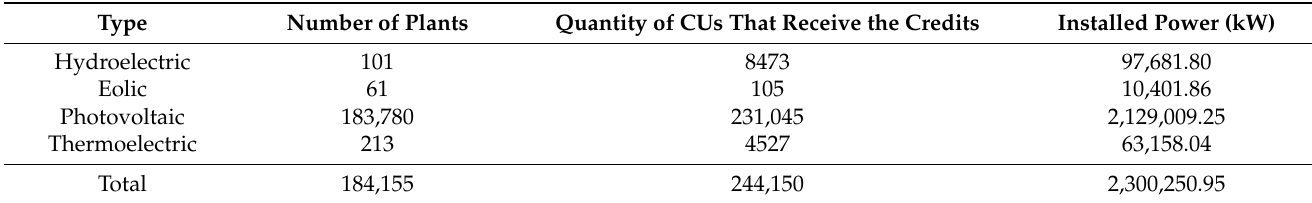
Table 2. Consumer units with distributed generation until February